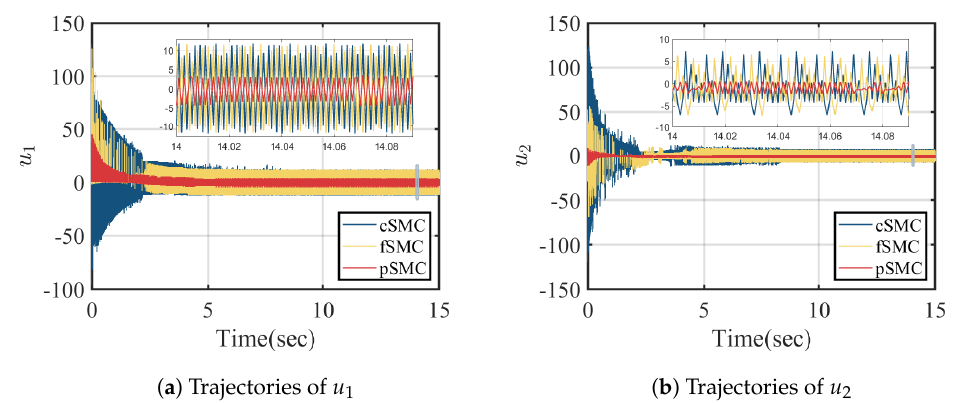
Figure 3. The trajectories of control variables u 1 and u 2 when ρ b = 0.9: cSMC (Blue solid line), fSMC (Yellow solid line) and pSMC (Red solid line).